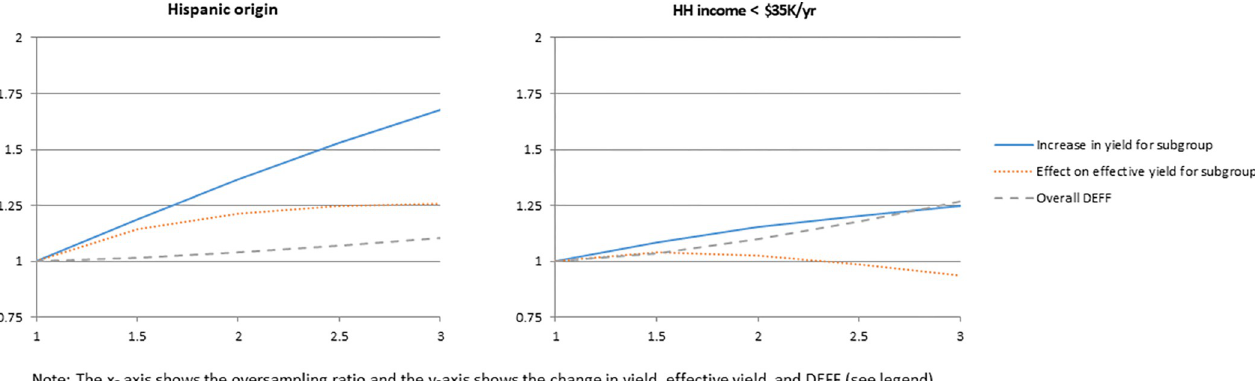
Fig 2. Effect of oversampling on yield, effective yield, and overall design effect (DEFF) for two appended demographic characteristics from ABS frame.